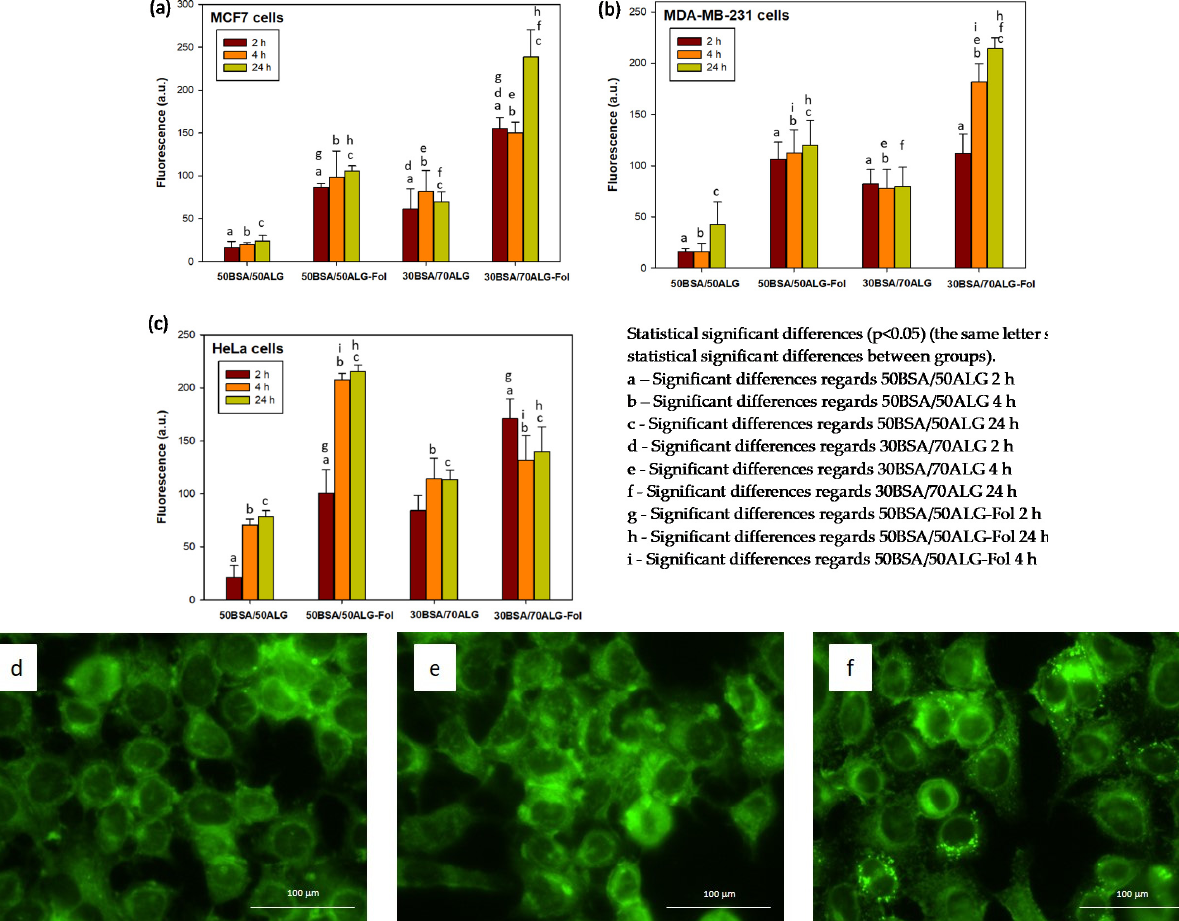
Figure 3. Quantitative comparison of coumarin-loaded internalized nanoparticles in ( a ) MCF-7, ( b ) MDA-MB-231 and ( c ) HeLa cells. Fluorescence microscopy images of coumarin-loaded internalized nanoparticles 50BSA/50ALG–Fol into MCF-7 ( d ), MDA-MB-231 ( e ) and HeLa ( f ) after 4 h of incubation.